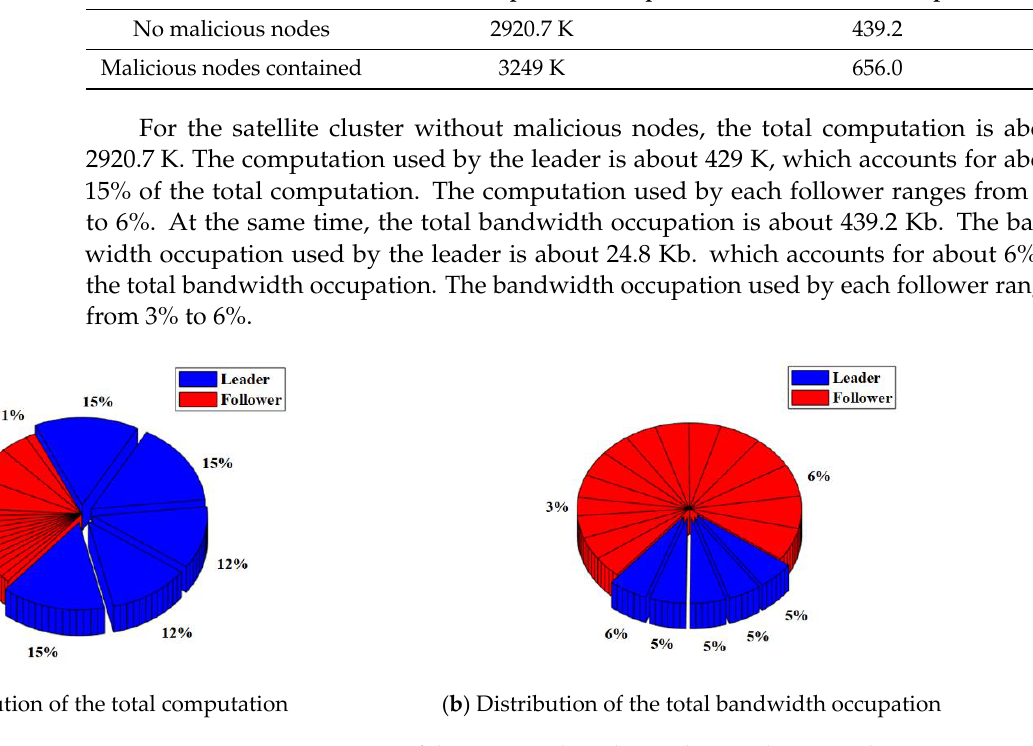
( b ) Distribution of the total bandwidth occupation Figure 13. Resource occupation of the RIPPLE algorithm with malicious nodes.